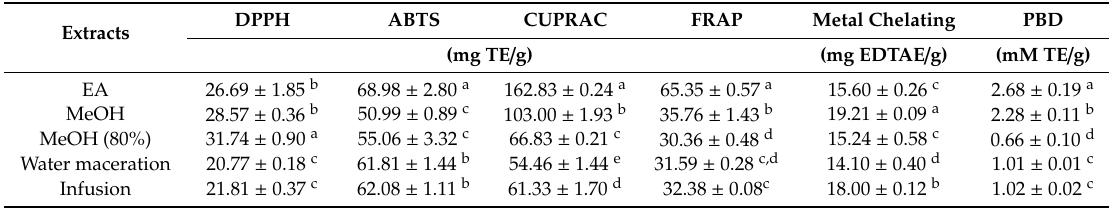
Table 4. Antioxidant abilities of the tested